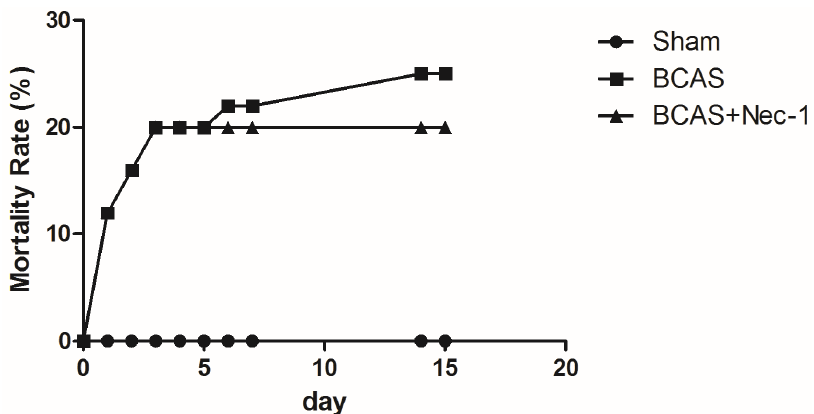
Figure 3. The mortality rate of the mice after surgery. The death of the mice occurred mainly in the first three days after surgery. The mortality rate in the BCAS group was lower than in the BCAS with Nec ‐ 1 group, but the difference was not statistically significant.